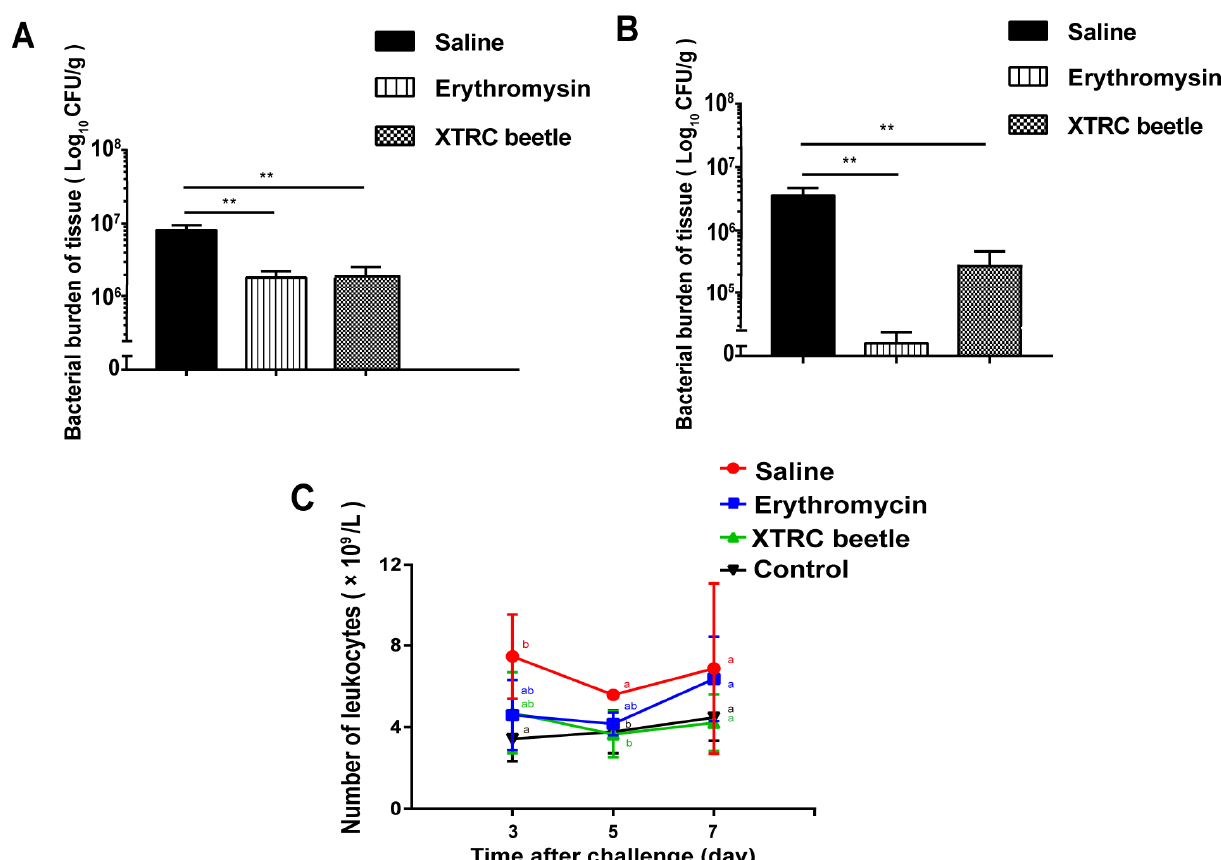
Figure 1. Effects of different treatments on bacterial load and peripheral blood leukocytes count in thermally injured and infected mice. ( A ) Bacterial load on wound of mice on day 3. ( B ) Bacterial load on the wound of mice on day 5. ** p < 0.01. ( C ) Results of leukocytes count in peripheral blood of mice on days 3, 5, and 7 after thermally injured and infection. Mean values at the same time point without a common superscript (a,b) differ significantly ( p < 0.05; Tukey’s test). The data are expressed as the mean ± standard error of the mean (SEM), n = 6.